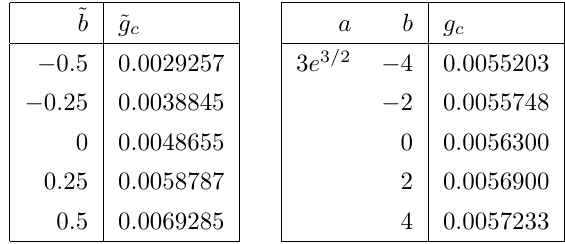
Figure 3 . The right (cid:12)gure shows the phase transition lines of the quadrakinetic model (4.19) within the second moment approximation for a = 0 and values of ~ b from left to right: (cid:0) 0 : 5 ; (cid:0) 0 : 25 ; 0 : 25 ; 0 : 5. The asymmetric one-cut to symmetric two-cut transition (4.30) is shown in red, the asymmetric one-cut to symmetric one-cut in green. The symmetric phase transition is not changed for small values of g and is the same as in the ~ b = 0 model diagram shown in gray. The left diagram is for the value a = 3 e 3 = 2 (cid:25) 13 : 45, i.e. as in the (cid:12)gure 2, and the values of b from left to right: (cid:0) 4 ; (cid:0) 2 ; 2 ; 4.